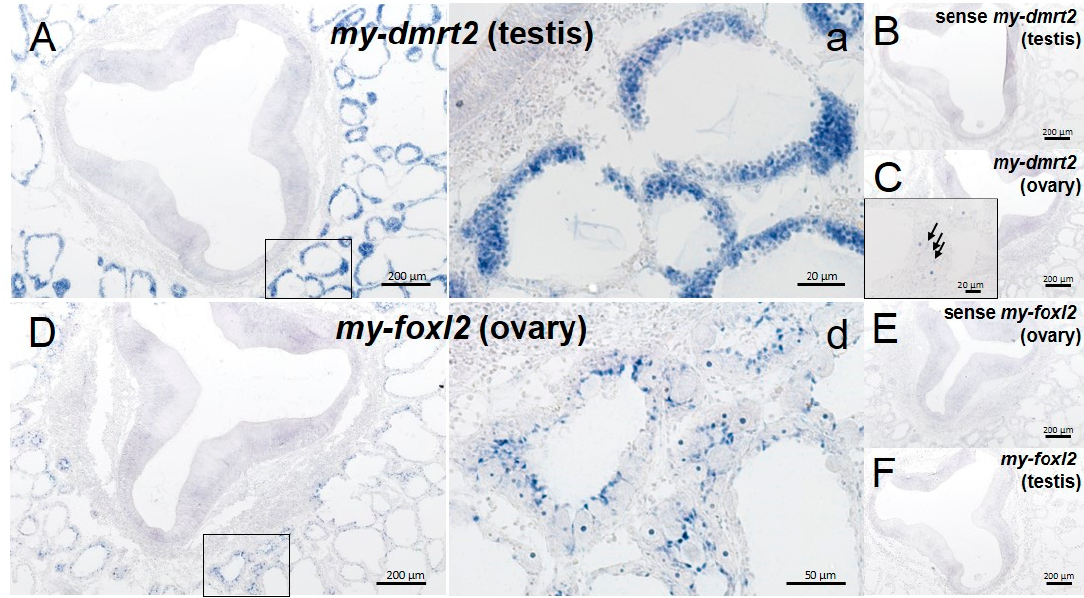
Figure 6. Localization of my-dmrt2 and my-foxl2 mRNAs in the Yesso scallop gonads. In situ hybridization (ISH) staining for my-dmrt2 (anti-sense probe, A and C ; sense probe, B ) and my-foxl2 (anti-sense probe, D and F ; sense probe, E) for testis and ovary. Black boxes in ( A ) and ( D ) indicate areas where high-magnification images were captured ( a and d ). Inset in C is a high-magnification view showing the faint signals of my-dmrt2 in ovarian cells (arrows).